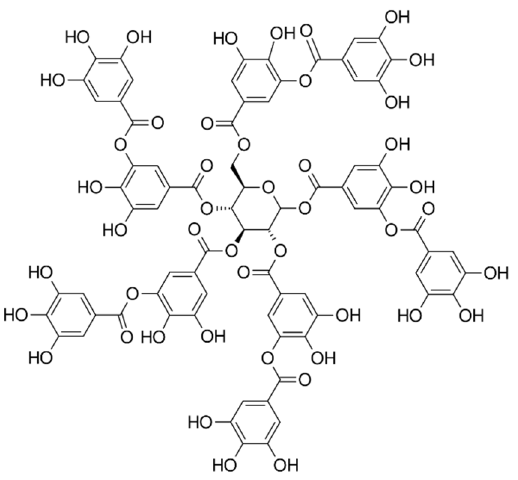
Figure 9. Chemical structure of tannin [137].